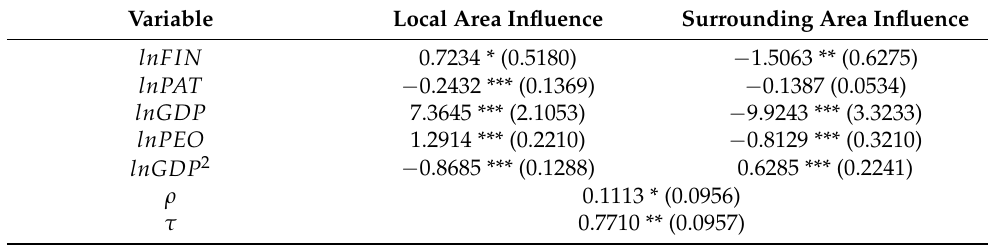
Table 2. Regression results of dynamic spatial panel